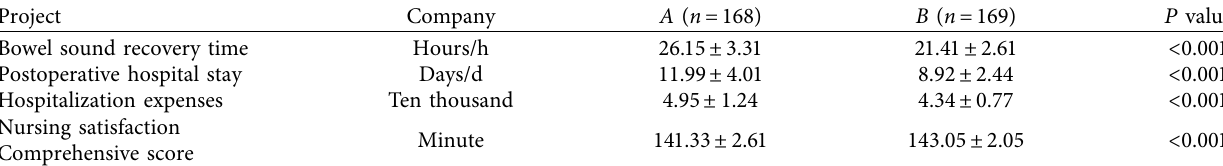
Table 3: Comparison of bowel sounds recovery time, postoperative hospitalization time, hospitalization expenses, and nursing satisfaction.